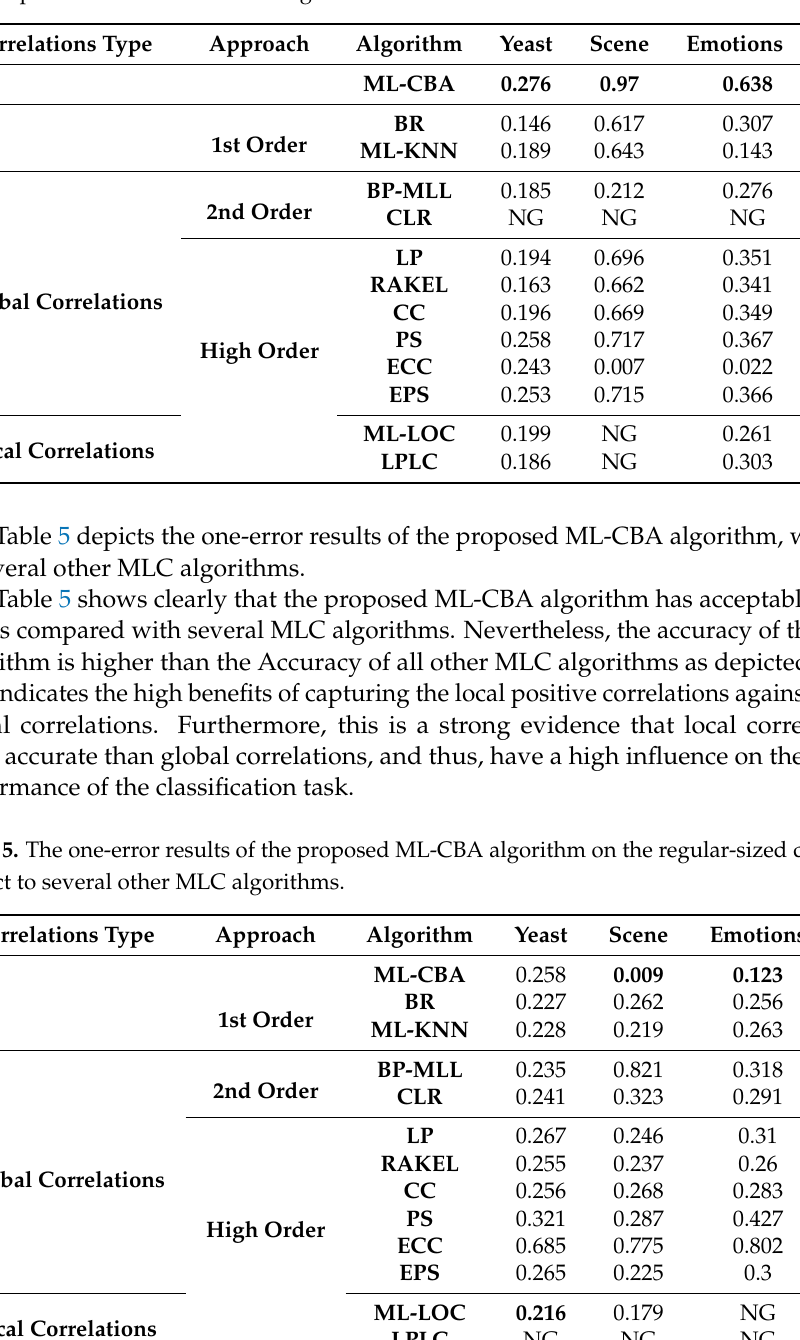
Table 4. The exact match results of the proposed ML-CBA algorithm on the regular-sized datasets with respect to several other MLC algorithms.